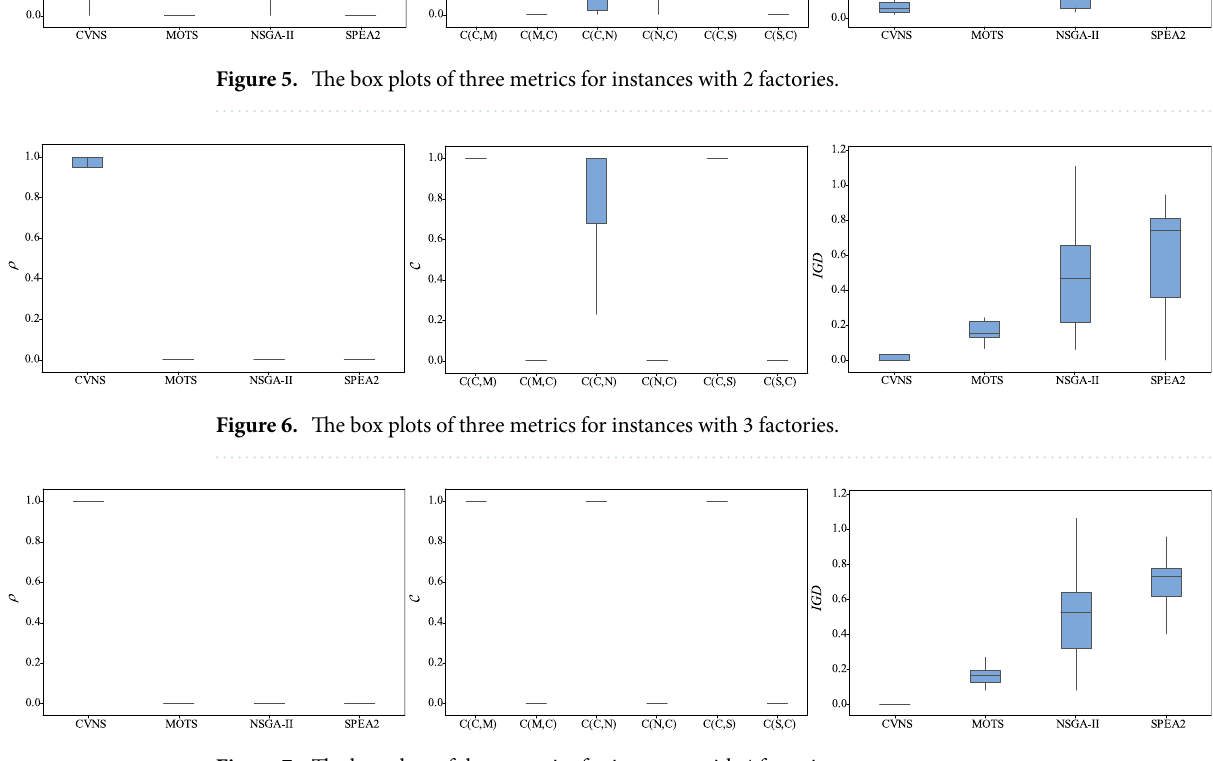
Figure 7. The box plots of three metrics for instances with 4 factories.